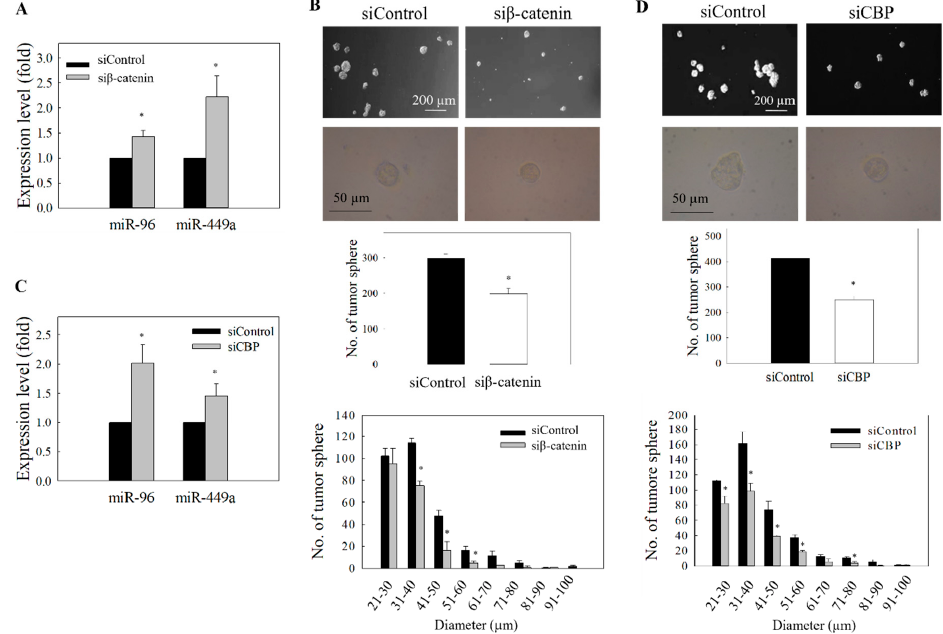
Figure 7. Effect of β -catenin and CBP knockdown on the expression of miR-96 and miR-449a. ( A ) C666-1 cells were transfected with β -catenin siRNA. Expression of miR-96 and miR-449a was determined by qRT-PCR. ( B ) Quantitative determination of tumor sphere formation and size profile after transfection of β -catenin siRNA. ( C ) Cells were transfected with CBP siRNA, and the expression of miR-96 and miR-449a was determined by qRT-PCR. ( D ) Quantitative determination of tumor sphere formation and size profile after transfection with CBP siRNA. At least three independent experiments were carried out. * p < 0.05 compared with corresponding